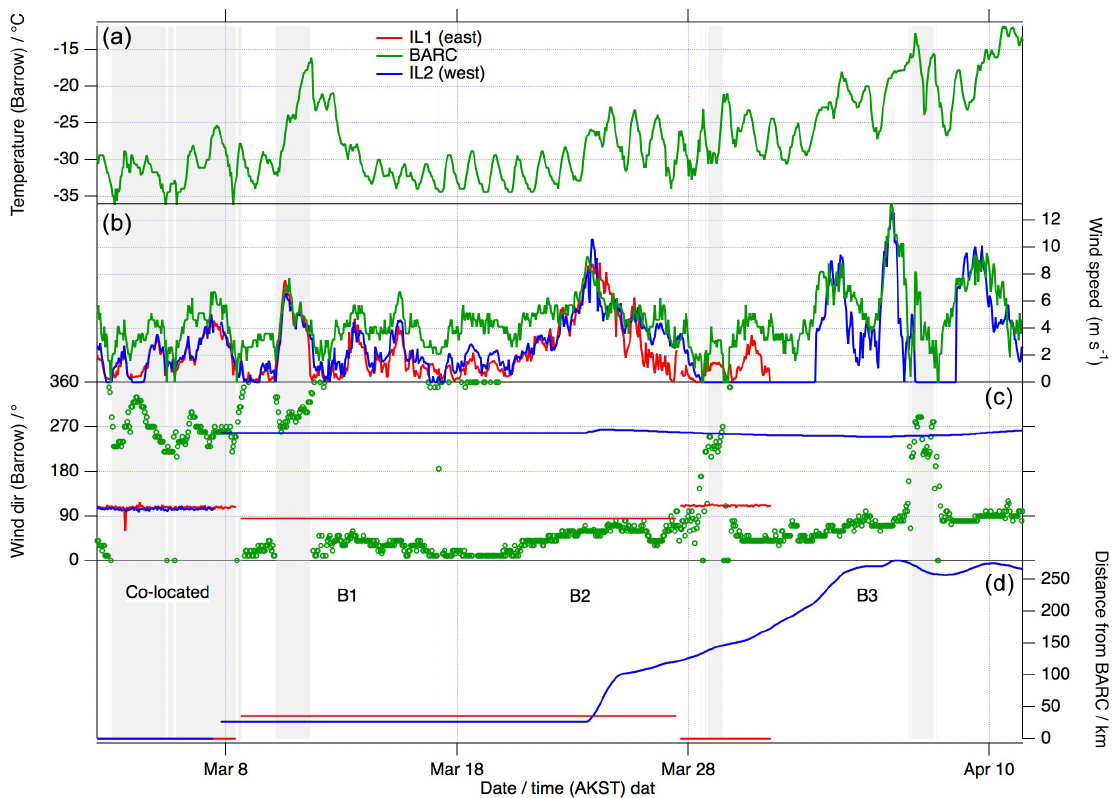
Figure 2. Meteorological data from the BROMEX campaign and drift information of IL1 and IL2. Panel (a) shows Barrow (Utqia˙gvik) temperature (2ma.g.l.) measured at the NWS-AWOS site. Panel (b) shows wind speed at all three sites, but the Barrow winds were measured at 10ma.g.l., while IL1 and IL2 were measured at 2.5ma.g.l. Panel (c) shows wind direction at Barrow (Utqia˙gvik, green circles) and in blue and red lines the direction of the IL platforms from the BARC building. The wind direction was bimodal (Fig. S2); west winds are plotted with a shaded background, and east winds without shading. Panel (d) shows the distance of the IL platforms from BARC. Both IL platforms started at BARC and were deployed on 8 and 9 March. On 23 March, IL2’s sea ice broke away from the land, starting its drift phase; on 27 March, IL1 returned to